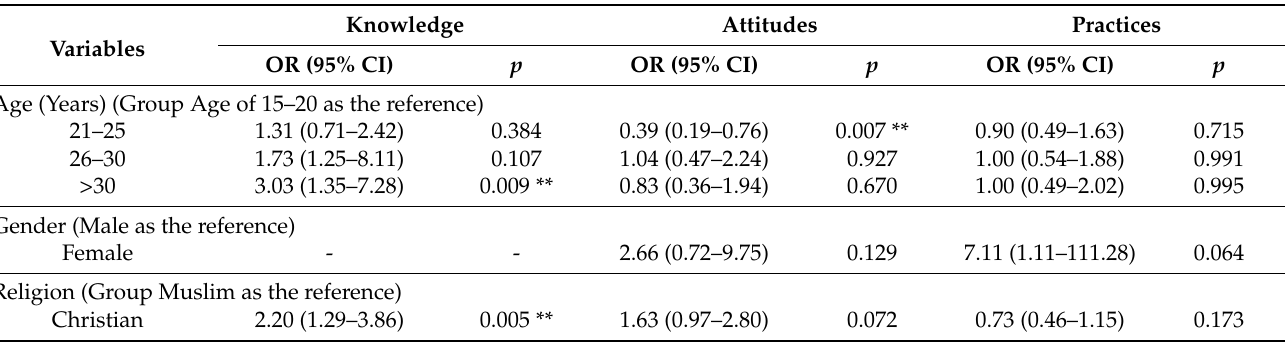
Table 3. Association of socio-demographic characteristics and KAPs scores of caregivers of children under-5 ( n =